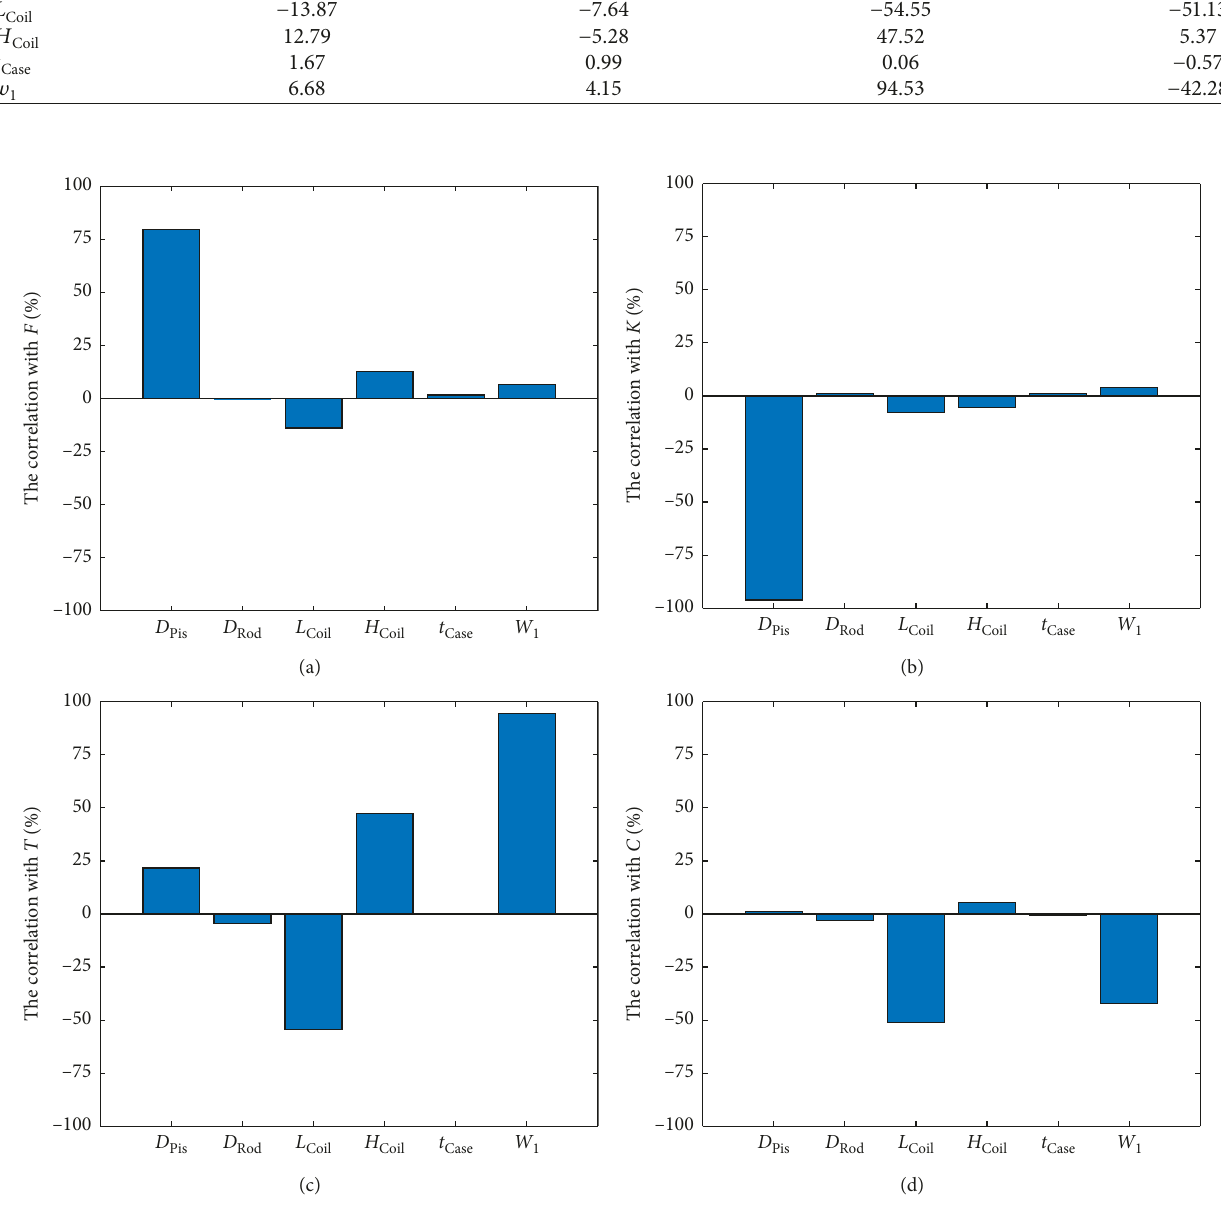
Figure 12: Correlation coefficient between the optimal objective and the geometric dimension parameters. (a) The correlation between F and geometric dimensions. (b) The correlation between K and geometric dimensions. (c) The correlation between ( T ) and geometric dimensions. (d) The correlation between C and geometric